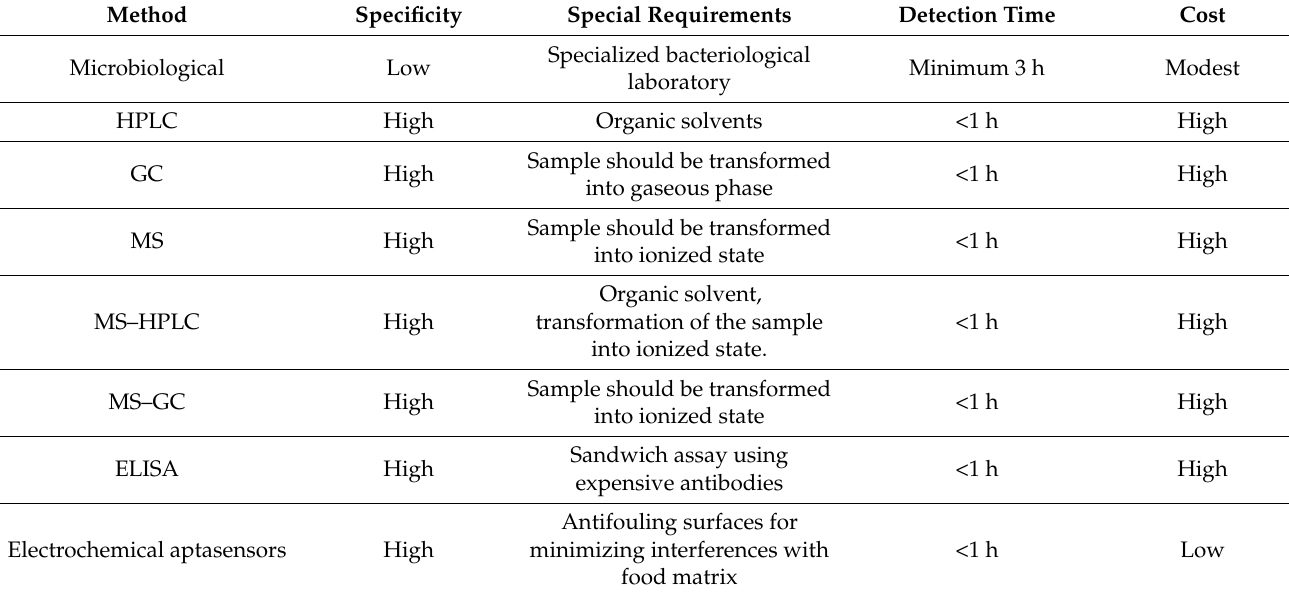
Table 3. Comparison of the general properties of the conventional methods of antibiotics detection with those based on electrochemical